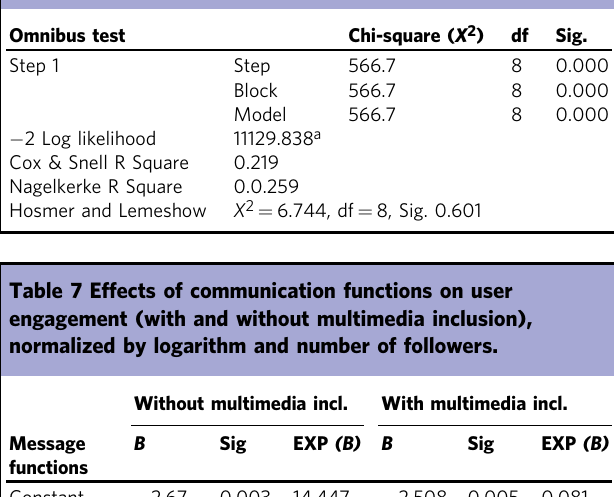
Table 6 Model fi t assessment.